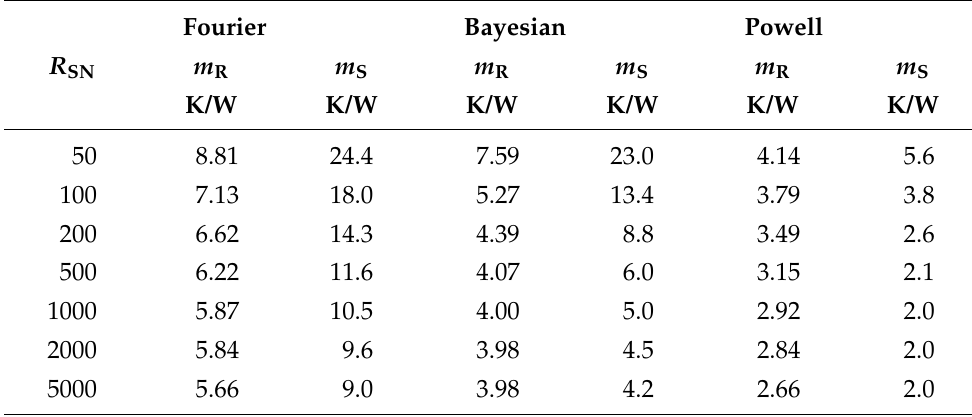
Table 3. Accuracy for all methods as a function of the signal-to-noise ratio, R SN .